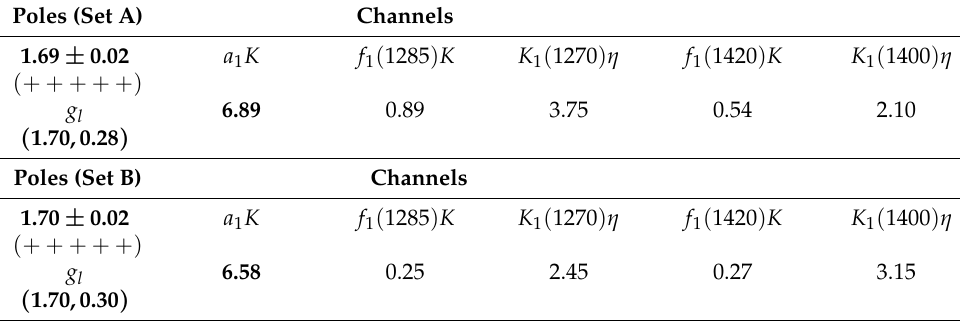
Table 12. Poles and their corresponding couplings to the channels contributing to the PA interaction with J P = 1 − . Here the flavor-neutral axial mesons have J PC = 1 ++ . The dominantly coupled channel is emphasized in boldface for each pole. The errors of the poles are from varying the subtraction constant within α ( µ = 1GeV ) = 1.35 0.17, and only the central values of the couplings are given. − ± The last row of each panel gives the central values of the peak mass and width ( M peak , Γ peak ) for the corresponding pole after considering the axial-vector meson